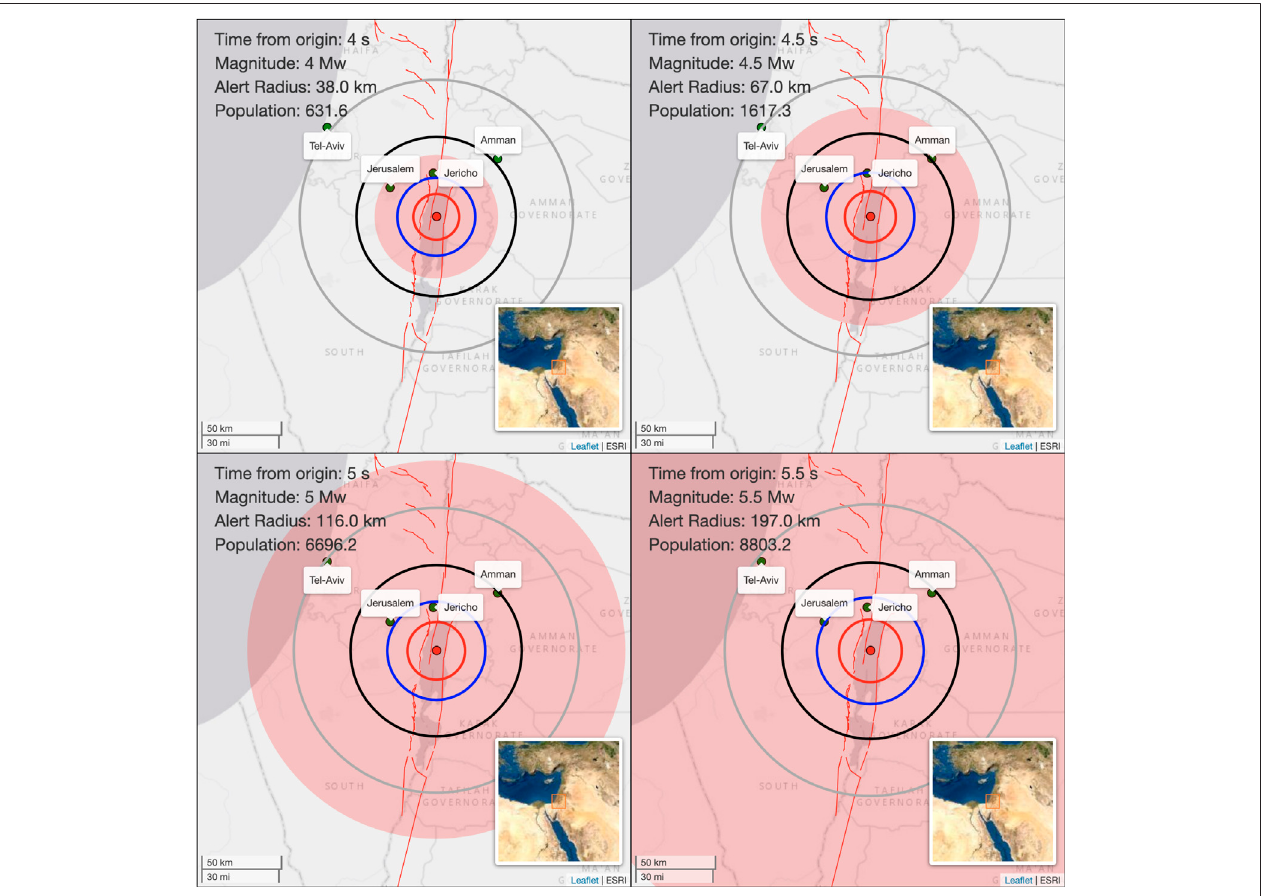
FIGURE 3 | “ Evolutionary ” EEW alert. With time, magnitude estimation is updated and the alerted area (pink) increases. Population numbers represent units of 1,000peralertarea.Inadifferentscenario,wheremagnitudeestimationwouldnotincrease(e.g.magnitudeisstableatM w 4),thealertedareaisminimalandotherareas arenotdisturbed.Alertarealimitiscalculatedas2 cm/s 2 usingLiorandZiv(2018)GMPEaroundtheepicenter(redmark).BlueandredcirclesindicatethefrontoftheP- and S- waves, respectively. Black and gray circles are 10 s intervals for S-wave front e.g. the expected S-wave front within 10 and 20 s, respectively.